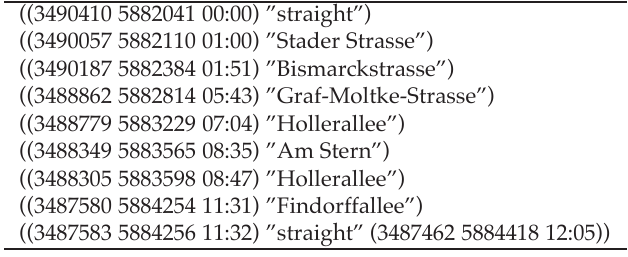
Table 1: An STC compressed